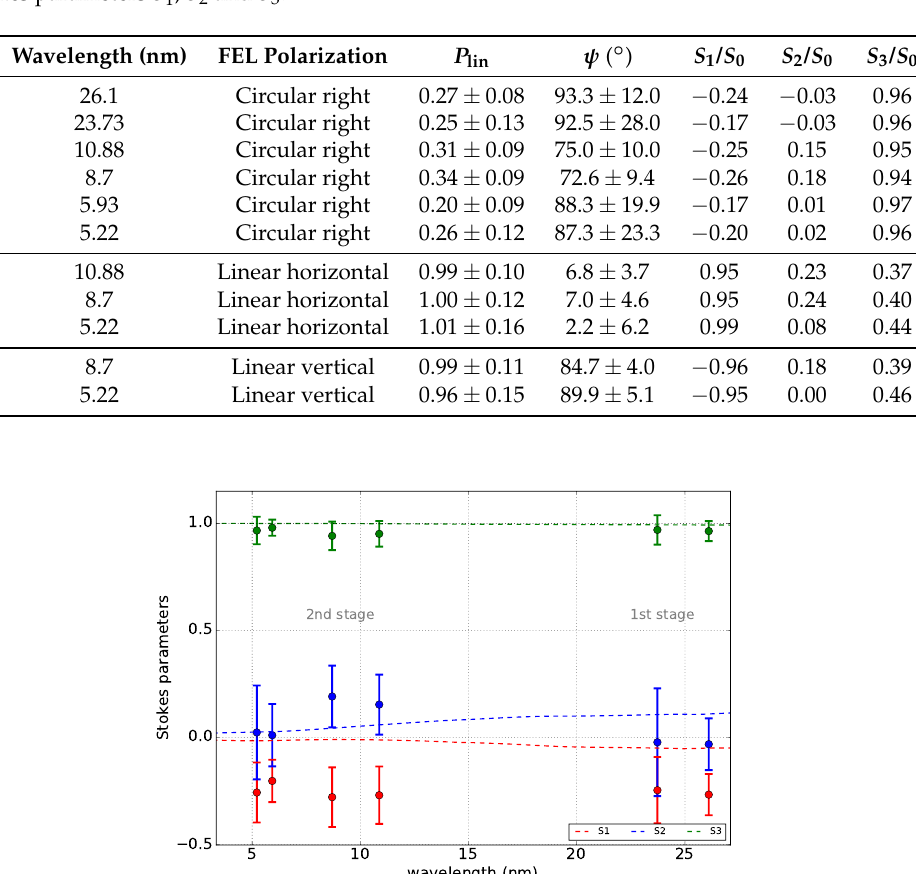
Table 4. Summary of the polarization measurements for various configurations of FEL-2 and deduced Stokes parameters S 1 , S 2 and S 3 .